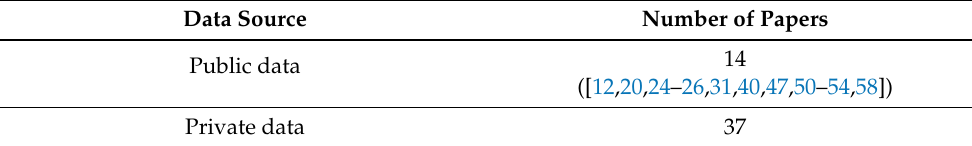
Table 5. Data source in the reviewed papers.